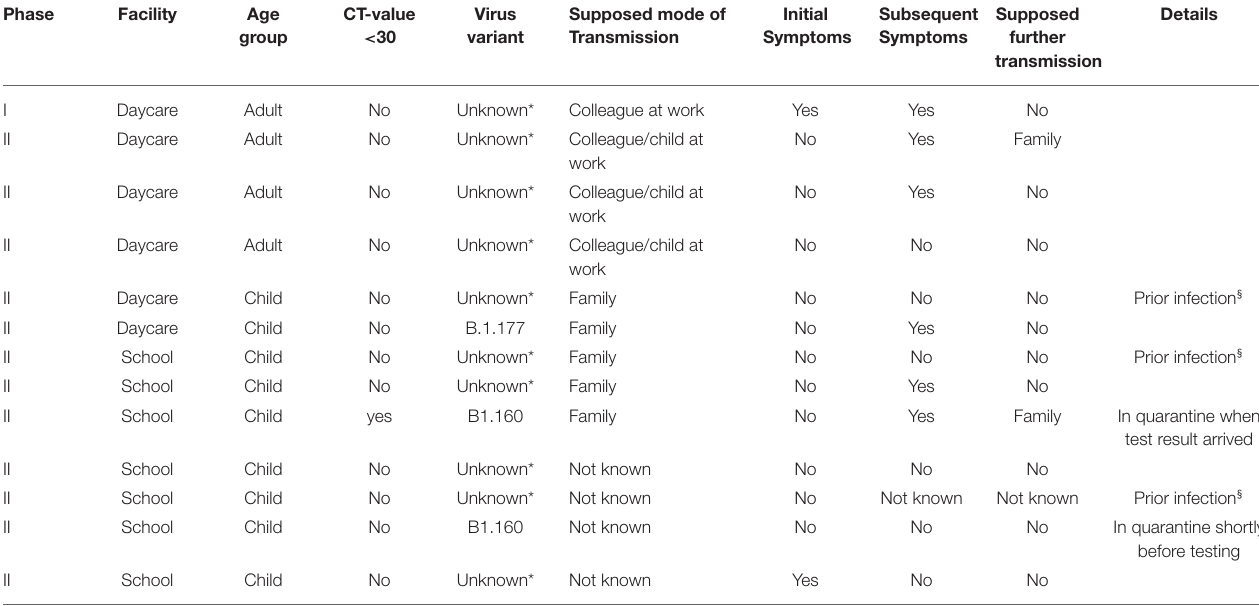
TABLE 2 | Characteristics of participants with positive test result.